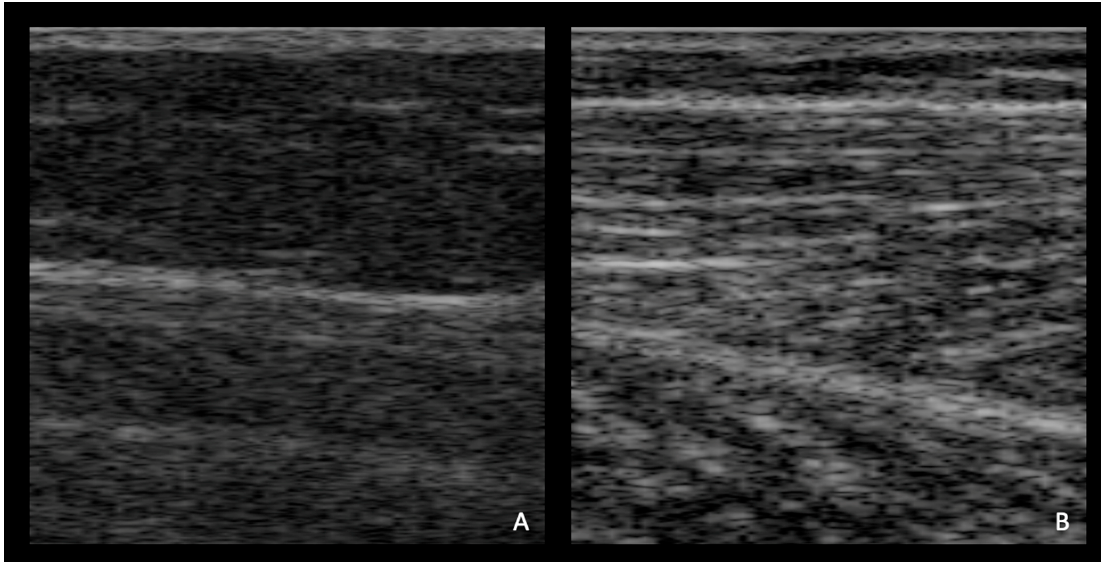
Figure 2. Randomly selected representative ultrasound images for ( A ) older adults and ( B ) young adults at 0.75 m/s 0.0° level ground. adults at 0.75 m/s 0.0 ◦ level